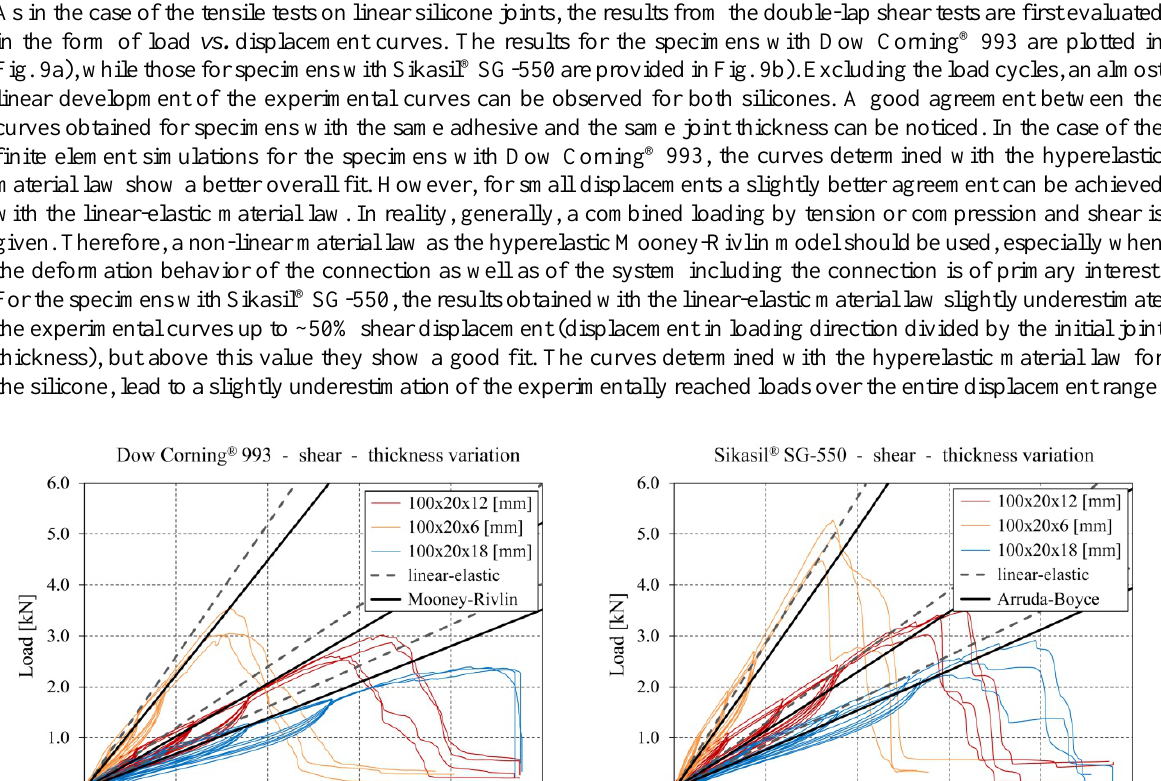
Table 5: Mean values for failure engineering stress and corresponding engineering shear displacement from the double-lap shear tests on glass- stainless steel joints.